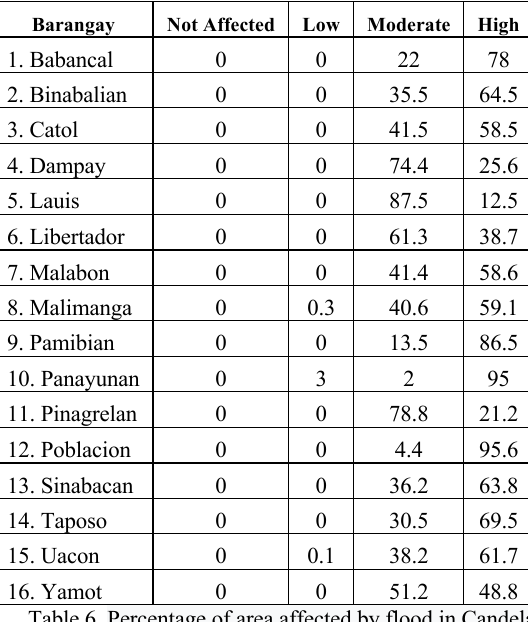
Table 6. Percentage of area affected by flood in